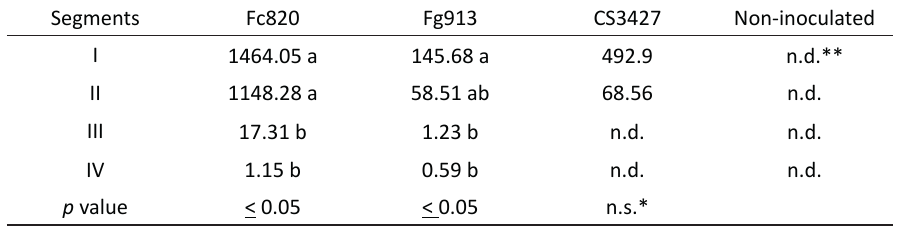
Table 2. Amount of fungal biomass, expressed as ng of fungal DNA g -1 plant dry weight, in the different barley segments following stem-base inoculation with F. culmorum (Fc820), F. graminearum (Fg913) and F. pseudograminearum (CS3427). p values indicate ANOVA test significance if p ≤0.05, letters (a,b,c) indicate significant differences between treatments following the post hoc Tukey HSD test.